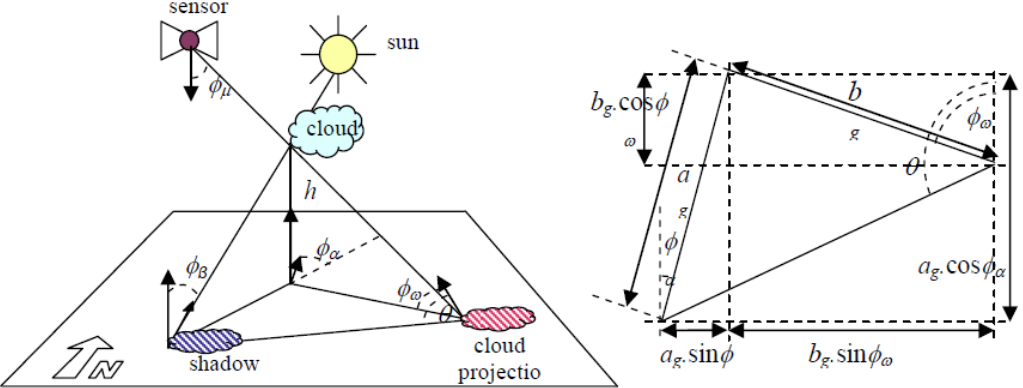
Figure 14. Adapted from [55]. Sun-cloud-satellite geometry for arbitrary viewing and illumination conditions. Left : Actual 3D representation of the Sun/cloud/cloud–shadow geometry. Cloud height, h , is a typical unknown variable. Right: Apparent Sun/cloud/cloud–shadow geometry in a 2D soil projection, with a g = h · tan φ β , b g = h · tan φ µ .